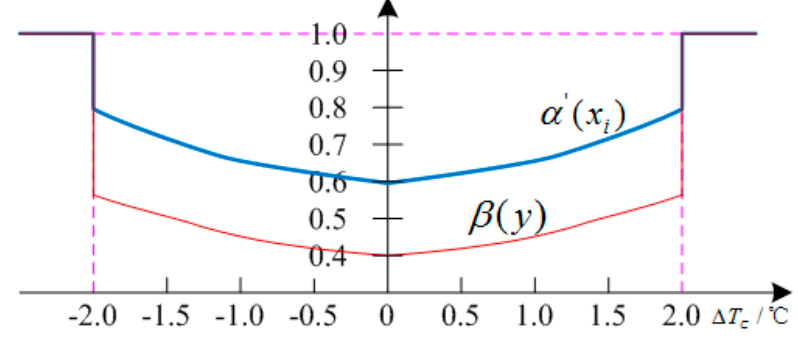
Figure 7. Curves of variable universe control factors.